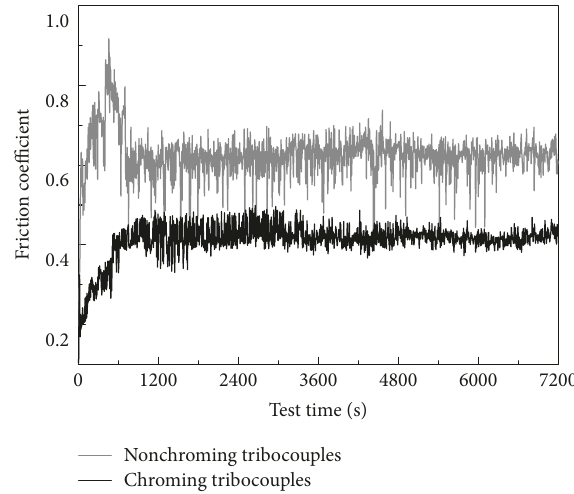
Figure2:Frictioncoefficientversusfrictiontimeforthenonchrom- ing and chroming friction